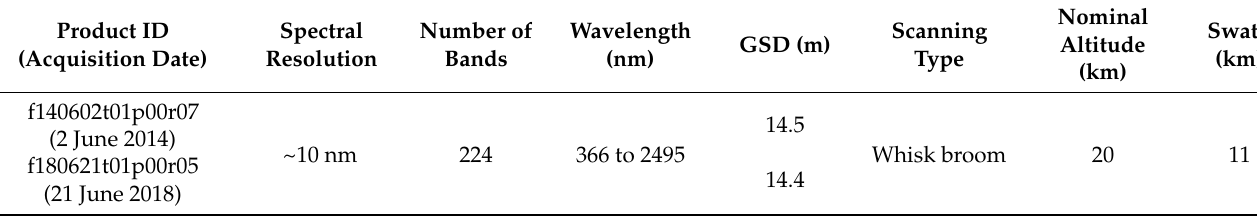
Table 1. AVIRIS data description used in this